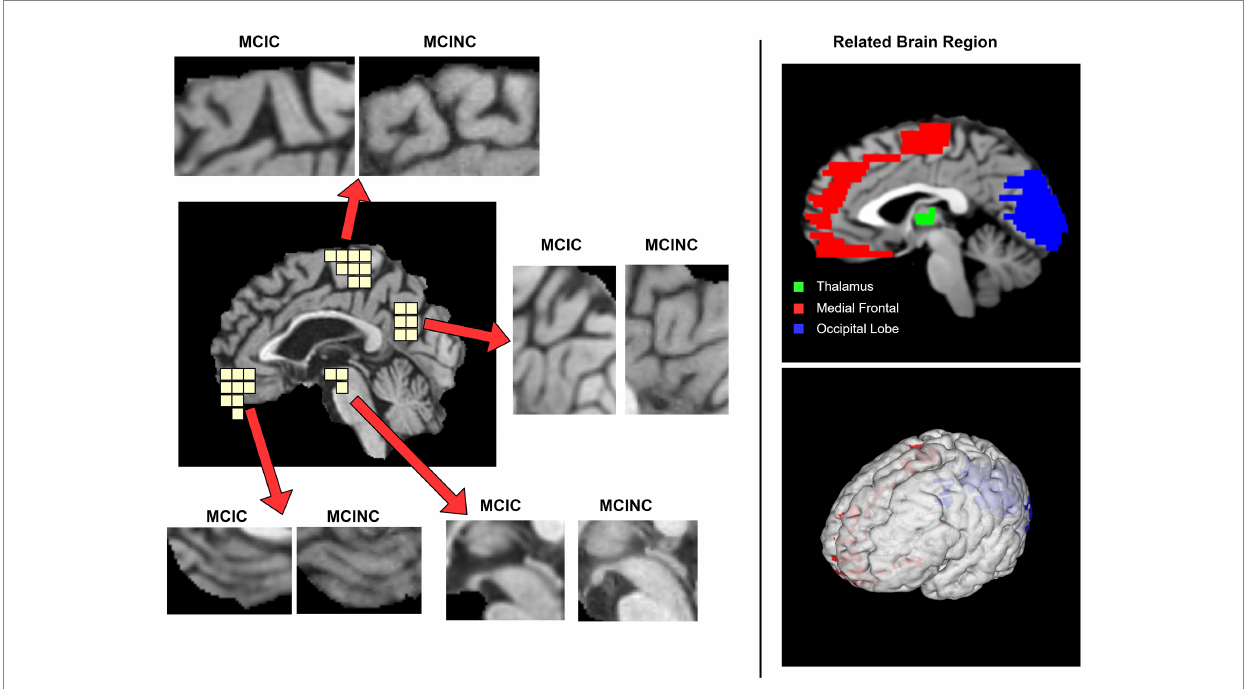
FIGURE 6 Visualization of the pathological sagittal brain region identified by proposed method on MCI-to-AD Progression Classification. The left panel shows the informative locations suggested by attention scores and the comparison between MCIC and MCINC classes in each region. The right panel shows the related brain region, respectively, with marked locations.